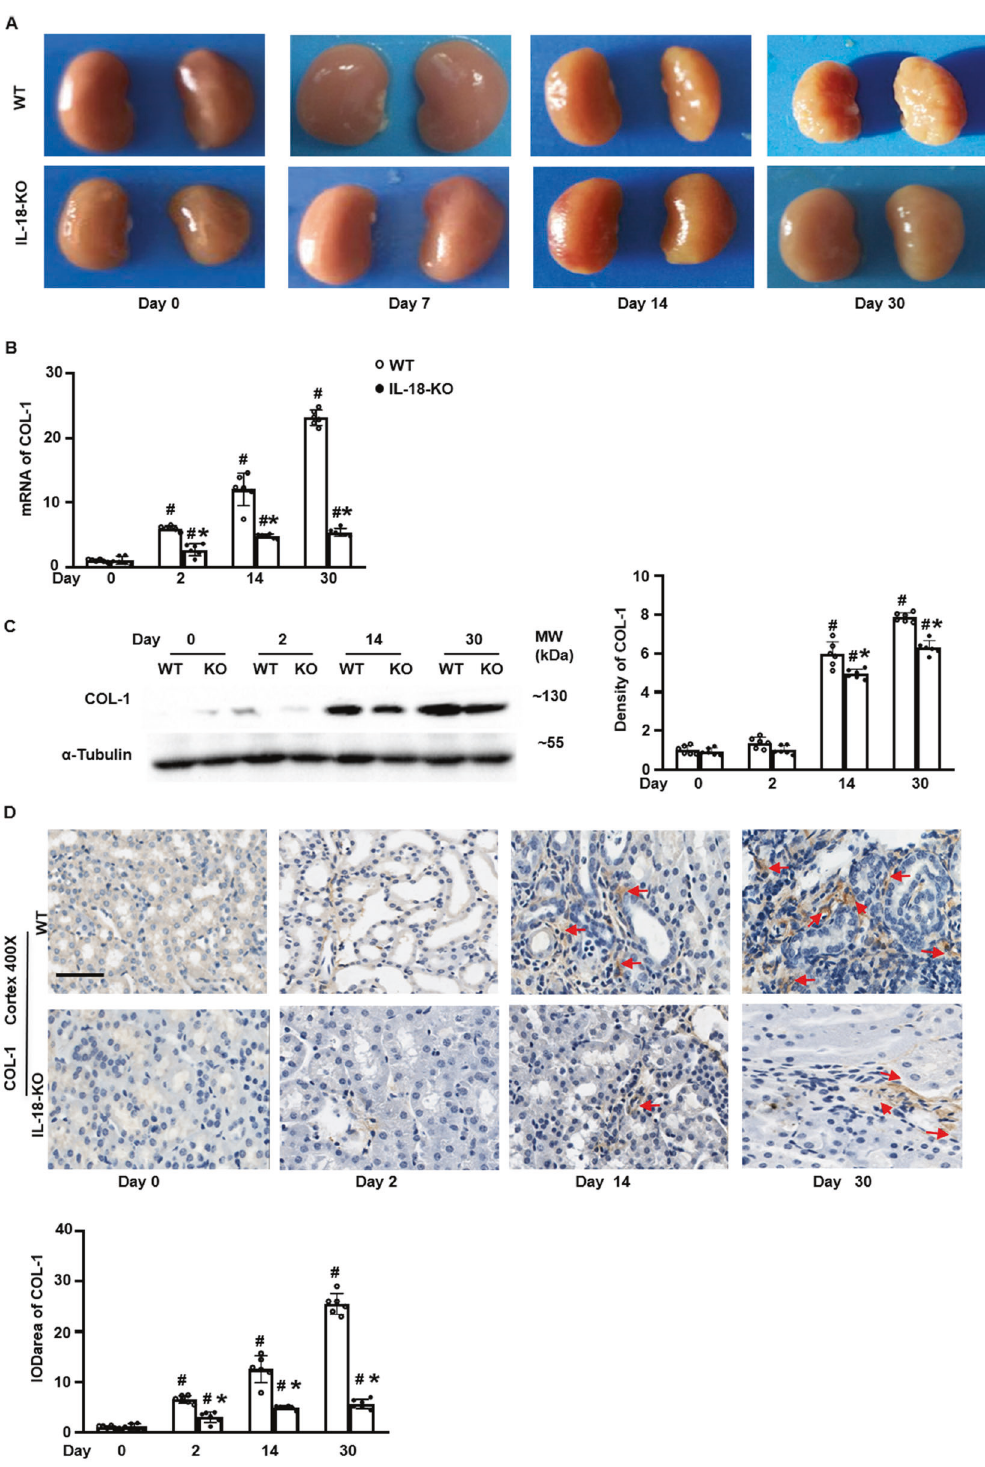
Fig. 4 IL-18 deletion inhibited renal fi brosis induced by folic acid. A The kidney size started shrinking from day 14 and became much smaller at day 30 after folic acid injection. B Renal mRNA expression of COL-1. C Renal protein expression of COL-1 analyzed by Western blotting and its semi-quanti fi cation. D Immunohistochemistry (IHC) staining and semi-quanti fi cation of COL-1 (red arrows) in renal cortex. Magni fi cation, 400×, bar = 50 um. Data represent Mean ± SD ( n = 6, # p < 0.05, other groups vs. day 0; * p < 0.05, KO vs. WT).